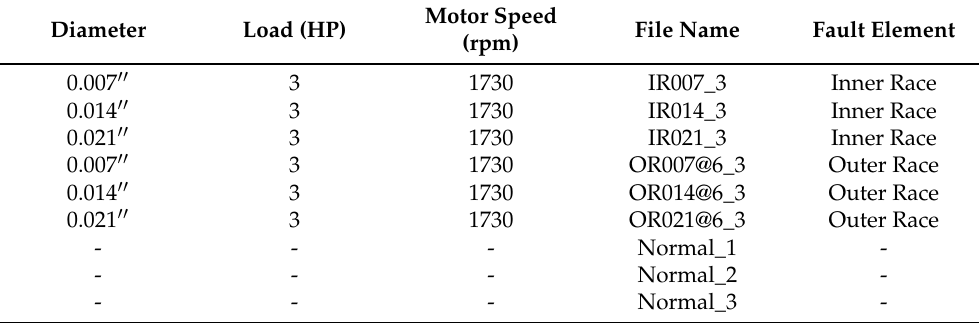
Table 3. Bearings selected from CWRU dataset.